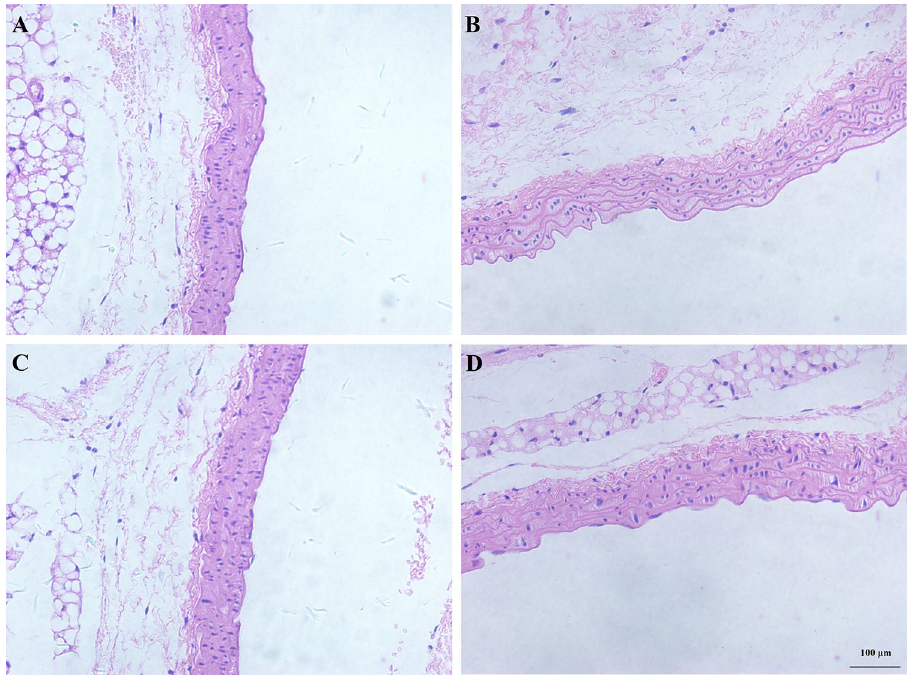
Figure 7. A photomicrograph of aortic tissues used for morphological analysis. ( A ) Con group, ( B ) LPS group, ( C ) Ex group, ( D ) Ex + LPS group [( A – D ) × 100